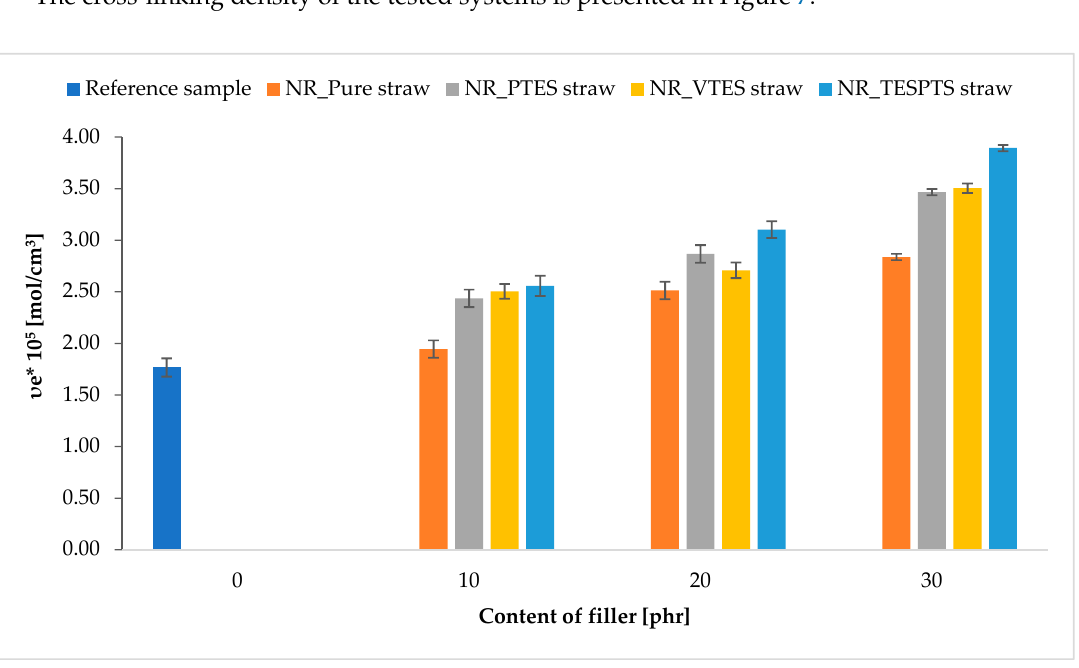
Figure 7. Impact of straw modifications and the fillers’ content on the cross-linking density of biocomposites.